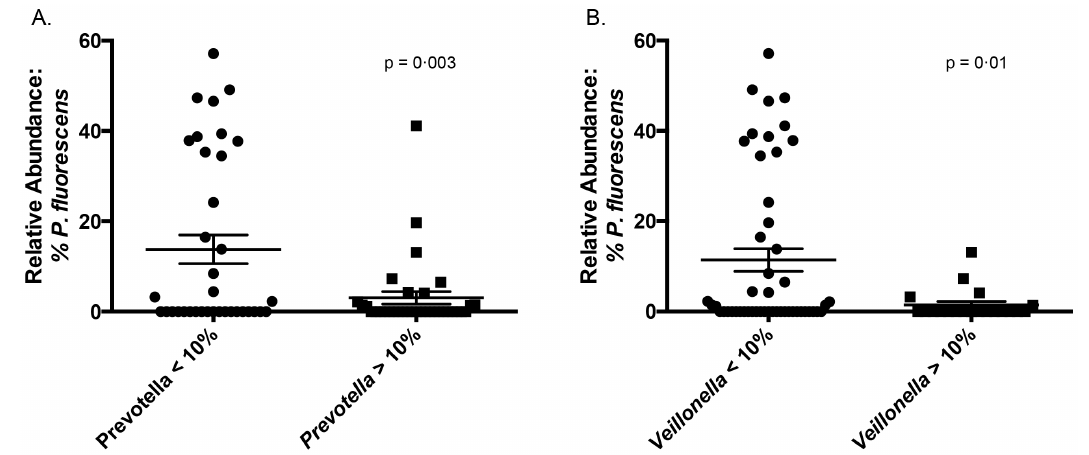
Figure 7. Invivo associations between P.fluorescens (OTU 1025) and other prominent bacteria: Prevotella (A) and Veillonella (B). Group means compared using unpaired t-test.